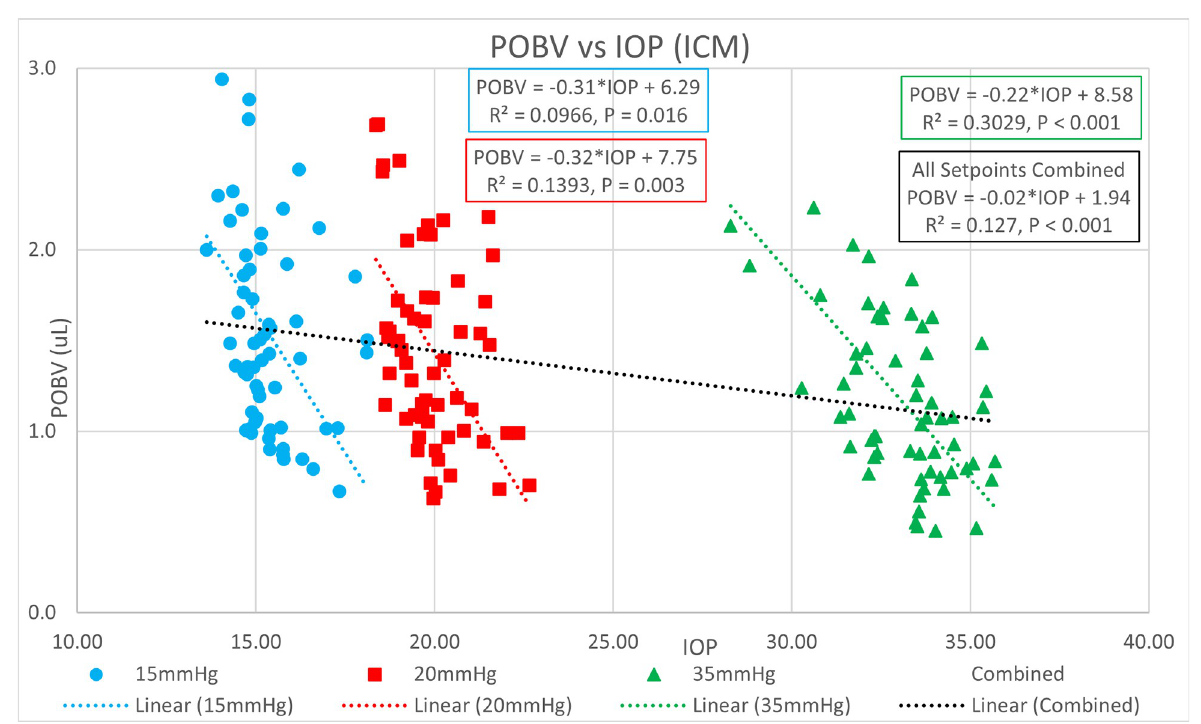
Fig 6. Negative correlation of POBV to IOP for ICM measurements.